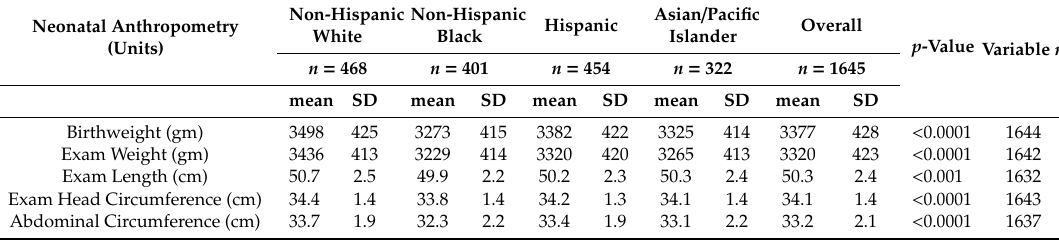
Table 2. Means and standard deviations for neonatal anthropometry measures by race / ethnicity. Neonatal Anthropometry